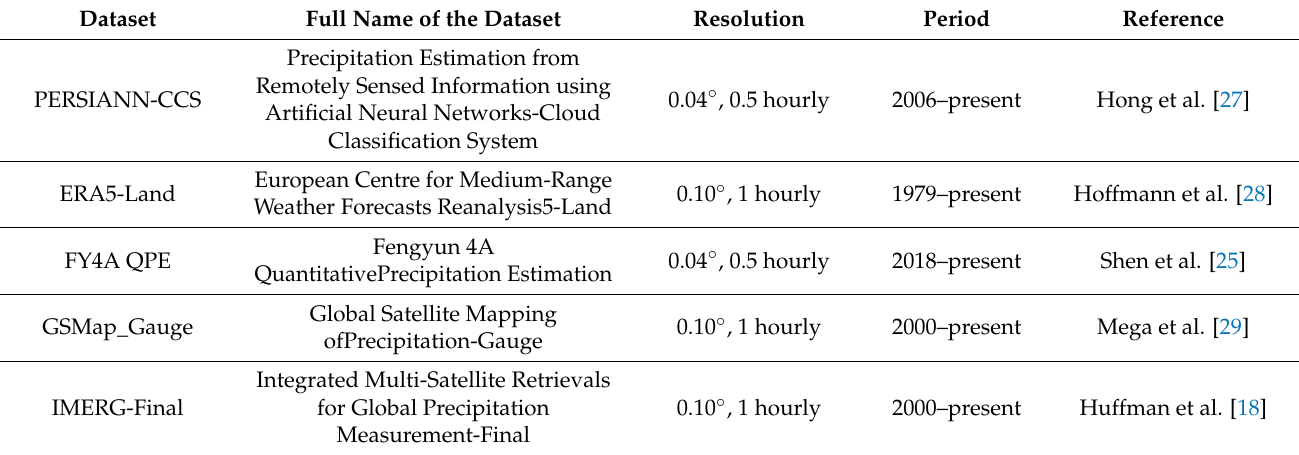
Table 1. Summary of satellite-based and reanalysis precipitation datasets used in this study.